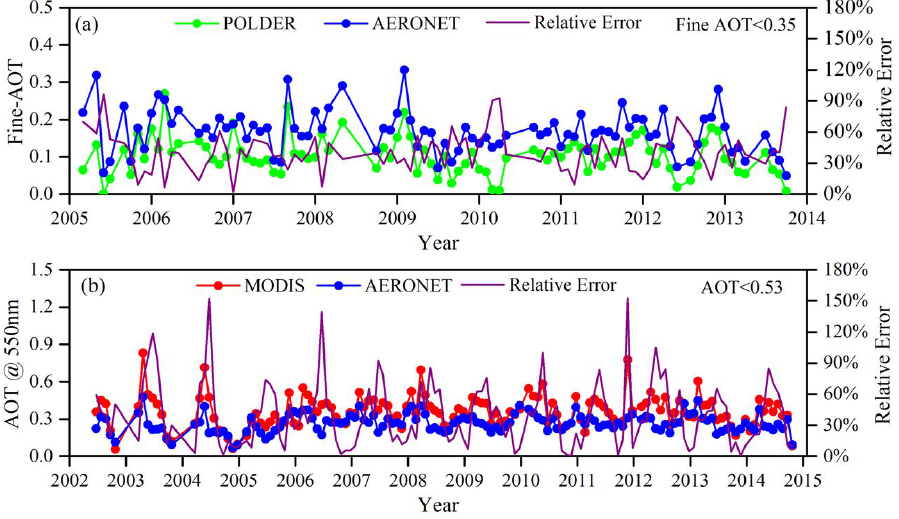
Figure 2. Identical to Figure 1 but for daily mean fine AOTs lower than 0.35 and for daily mean AOTs lower than